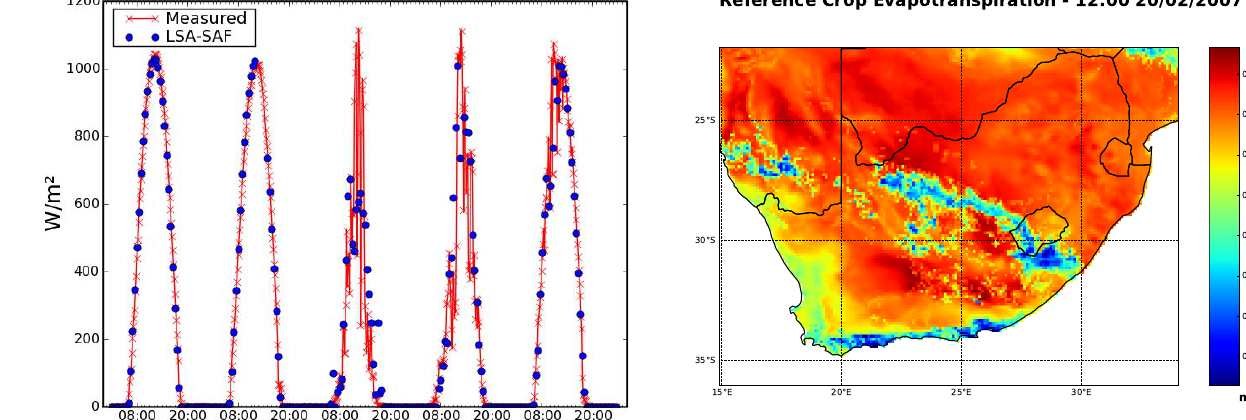
Fig. 3. Comparison of observed solar radiation with observations in KwaZulu-Natal, South Africa made by the CSIR (C. Everson, personal communication, 2008). The blue points are the half-hourly DSSF estimates from the LSA-SAF product and the red crosses are the data observed at the ground, measured at 12 min intervals.